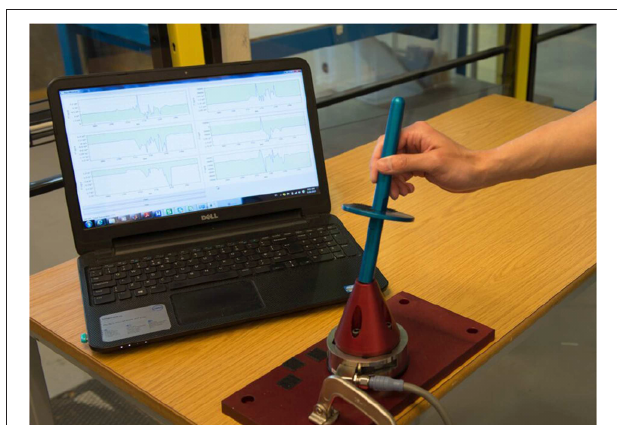
FIGURE 8 | The experiment setup during PiH